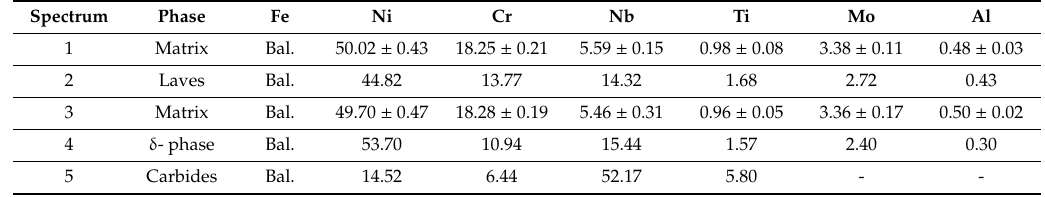
Table 4. EDS spot analysis results of the heat-treated conditions in Figure 11 (wt.%).